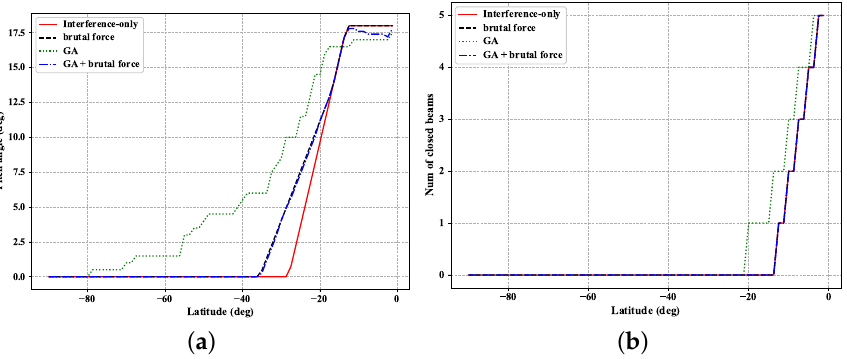
Figure 5. The scheme of progressive pitch: ( a ) pitch angle vs. the latitude of LEO satellite; ( b ) number of off beams vs. the latitude of the LEO